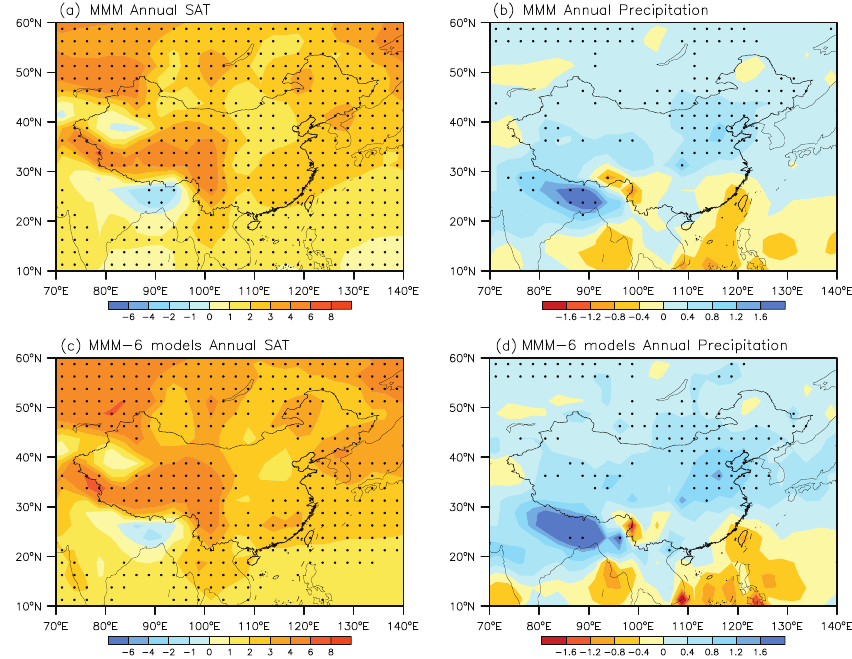
Fig. 6. Same as Fig. 4, but for annual mean SAT (left column, units: ◦ C) and precipitation differences (right column, units: mmday − 1 ) . The areas with confidence levels larger than 95% using Student’s t test are dotted. The standard deviation of the simulated annual SAT and precipitation changes can be seen in Fig. S6.